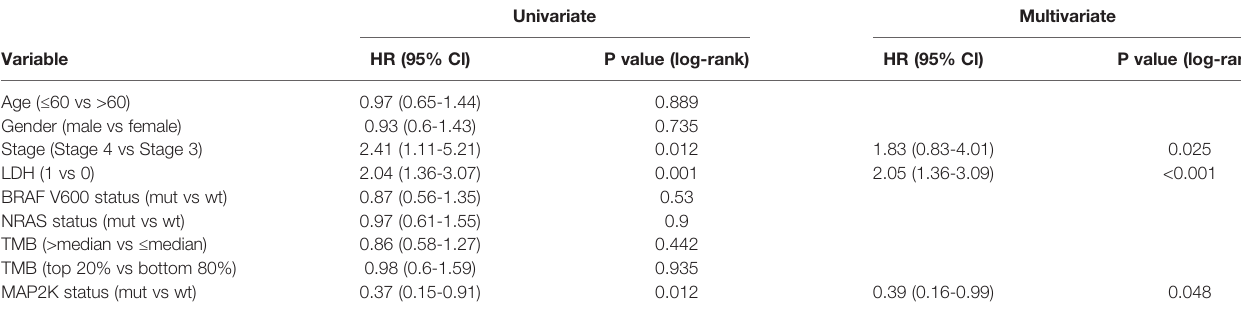
TABLE 1 | (b) Hazard ratio (HR) for PFS via univariate and multivariate analyses in discovery cohort. Univariate